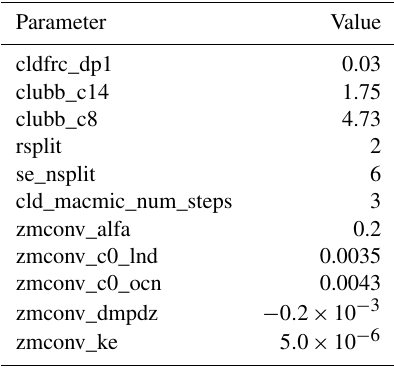
Table A2. Non-default parameter